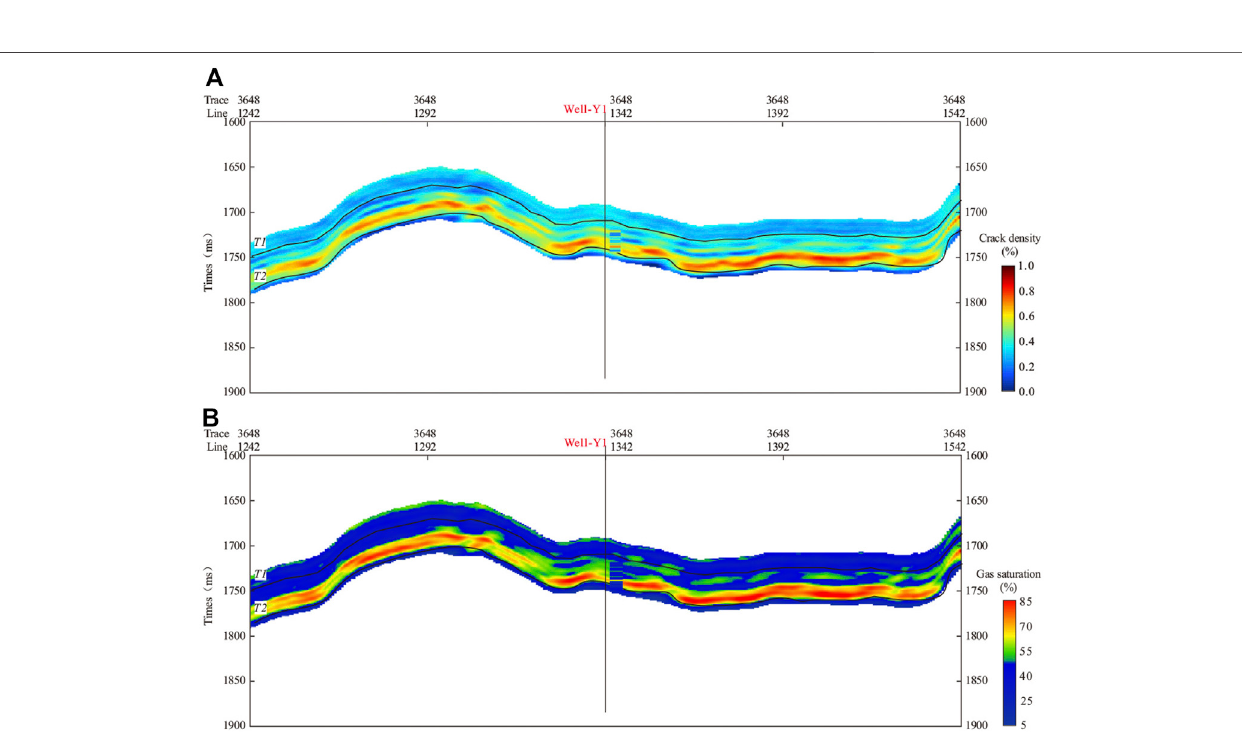
Frontiers in Earth Science |